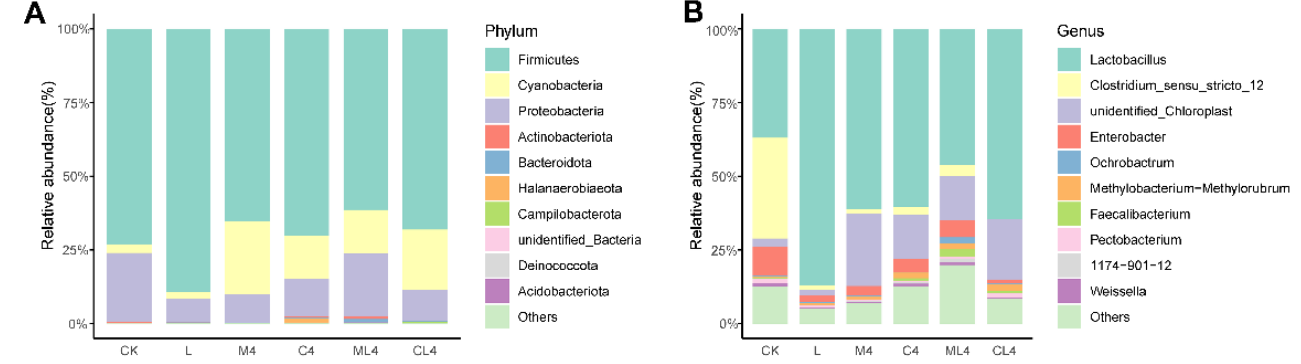
Figure 5. Bacterial community and relative abundances at the phylum ( A ) and genus ( B ) levels in Chamaecrista rotundifolia silage after 60 days of fermentation.